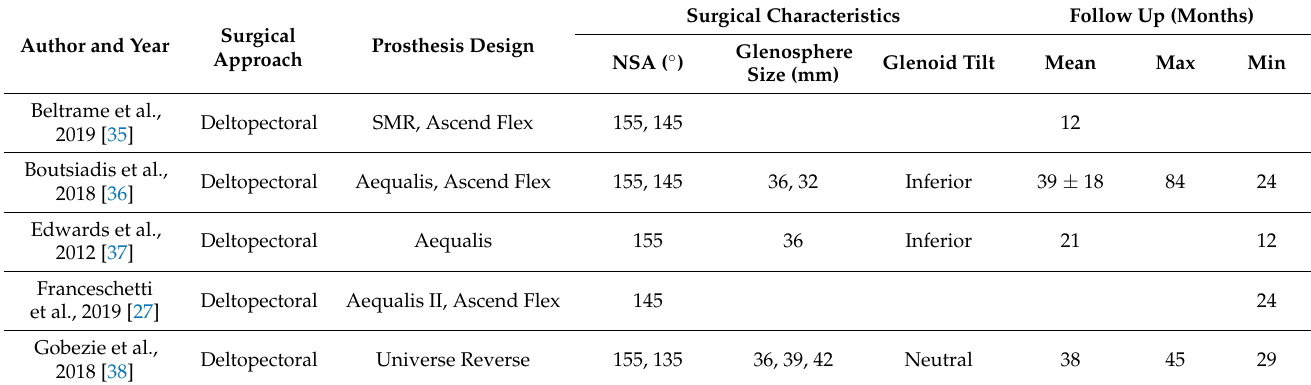
Table 2. Surgical approach, prosthesis design, surgical characteristics, and follow-up of the studies